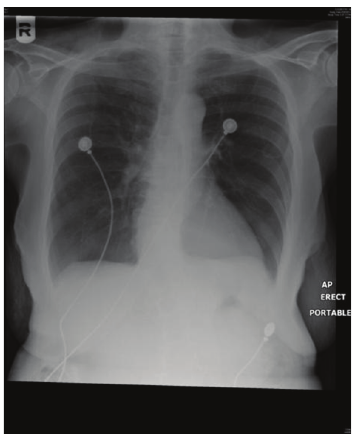
Figure 1: Preoperative chest X-ray: essentially normal.